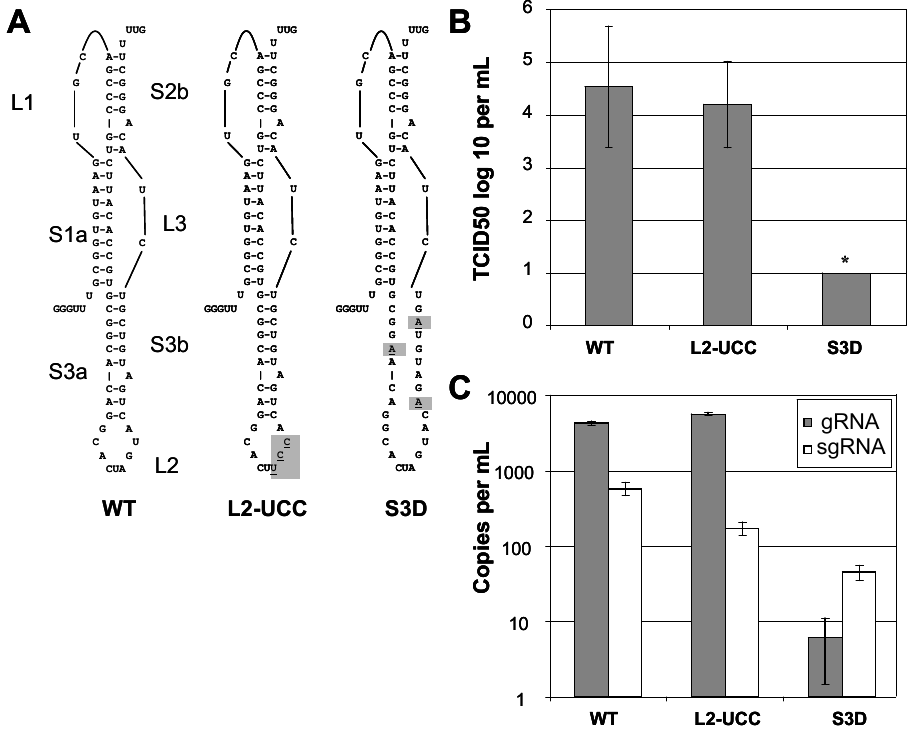
Figure 4. Mutations to stem 3 can affect virus infectivity and replication. ( A ) Schematic of the wild-type SARS pseudoknot and viral mutants. The specific bases that were altered are shaded and underlined. ( B ) Tissue culture infectious dose was determined as described in the materials and methods. The values shown are the average of six measurements with error bars showing the standard deviation. Asterisks indicate values that were at the lower limit of the assay. ( C ) Relative abundance of genomic and subgenomic RNA in viral stocks. Plaque purified virus was used to infect Vero cells. Four days post infection CPE was observed. Media and detached cells were removed. RNA was extracted from a 100 μ L aliquot using Trizol. Taqman analysis was used to determine the total number of genomic and subgenomic RNA molecules compared to a reference RNA transcribed from a SARS replicon. The number of copies per mL of viral stock is shown with standard deviation.